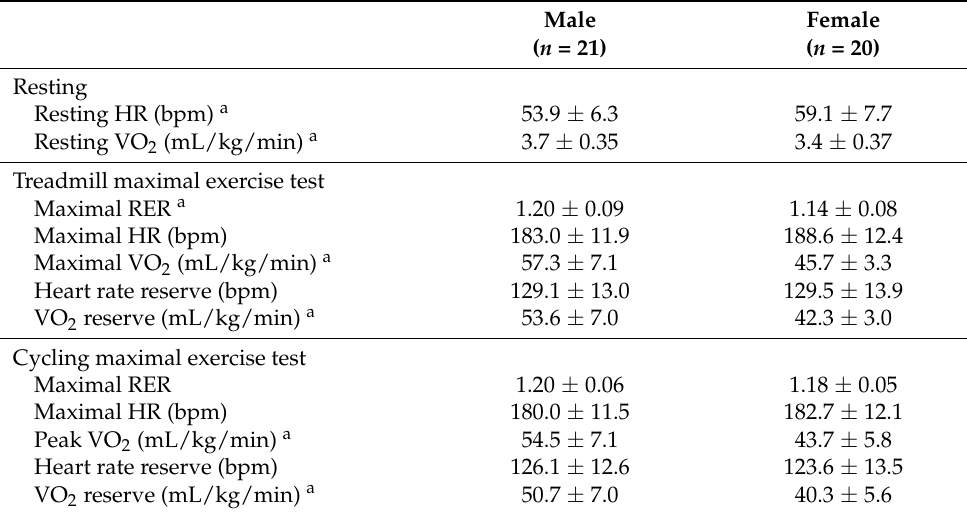
Table 2. Resting and maximal exercise test